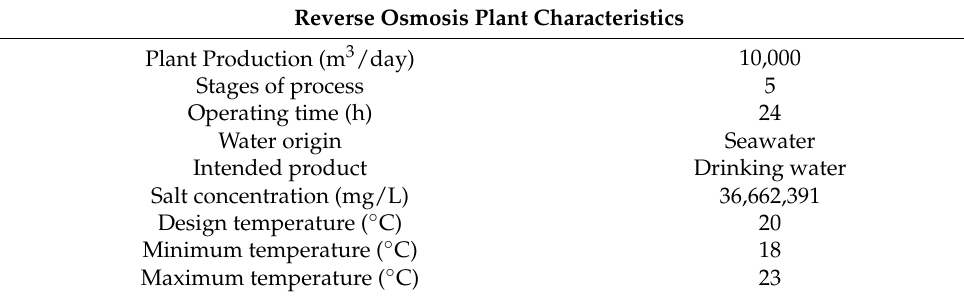
Table 9. Features of reverse osmosis